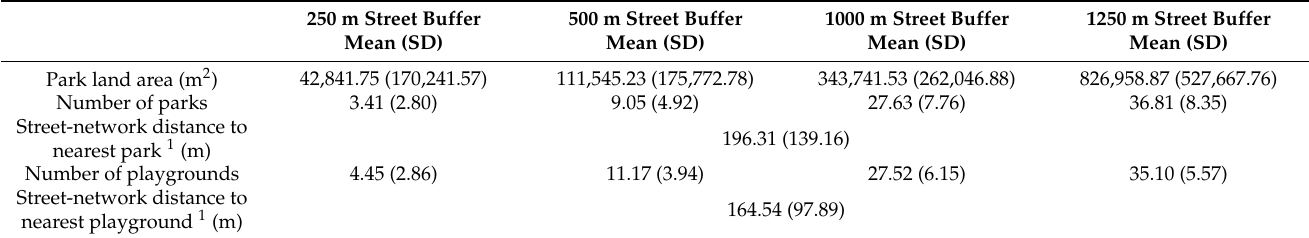
Table 2. Descriptive statistics of the park and playground variables for all study